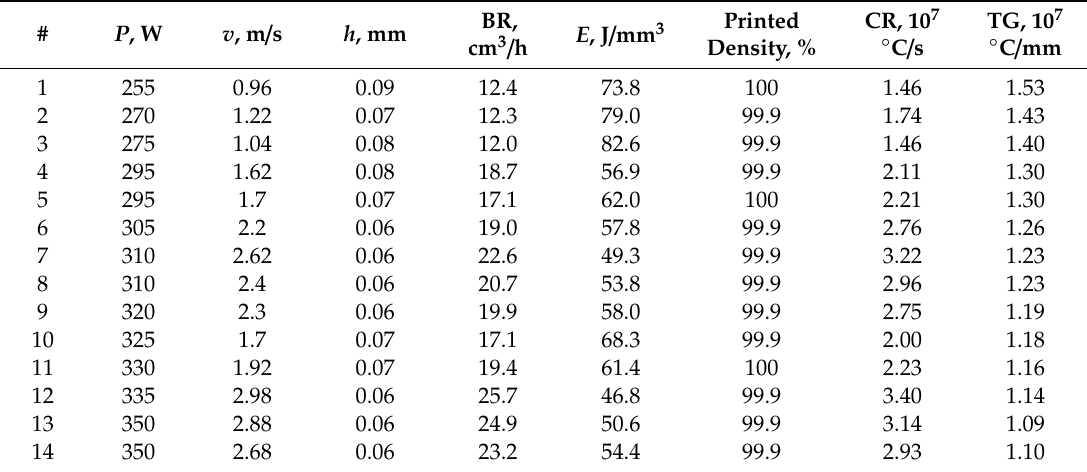
Table 2. Printing parameters ( t = 40 μ m) and calculated BR, E, Printed density, CR and TG.